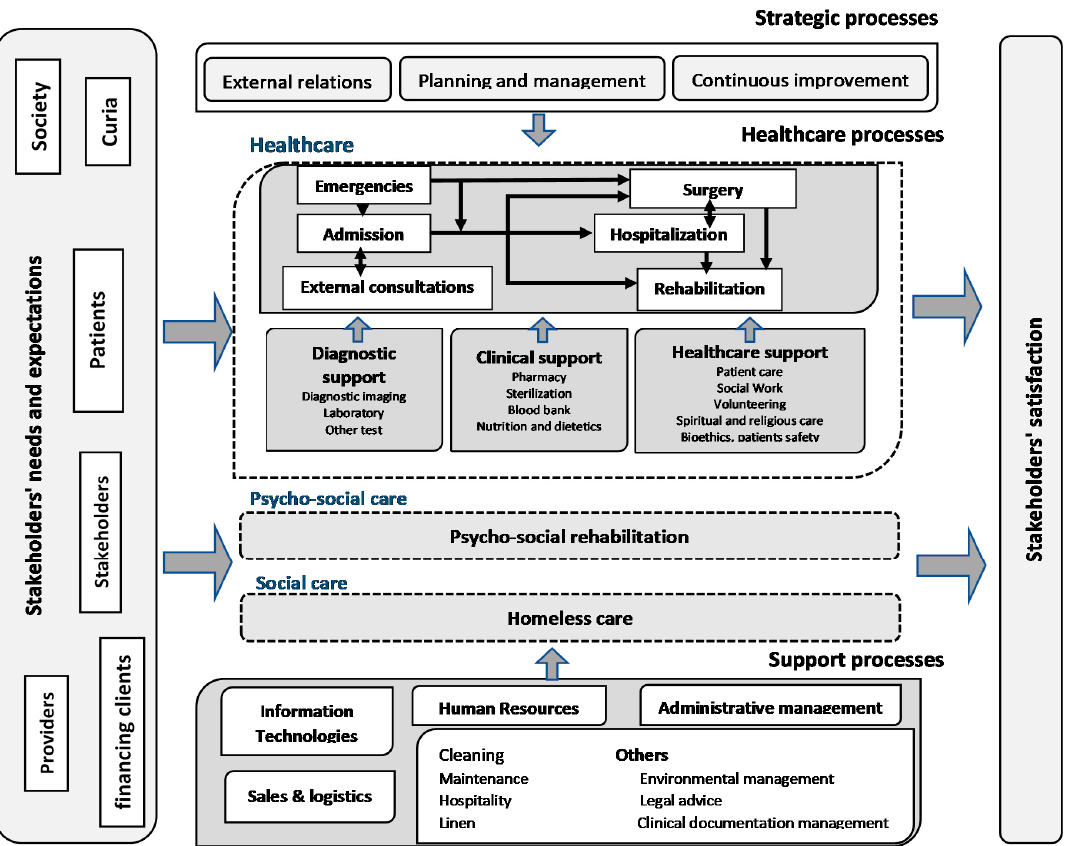
Figure A1. Source: Hospital Quality Management System.